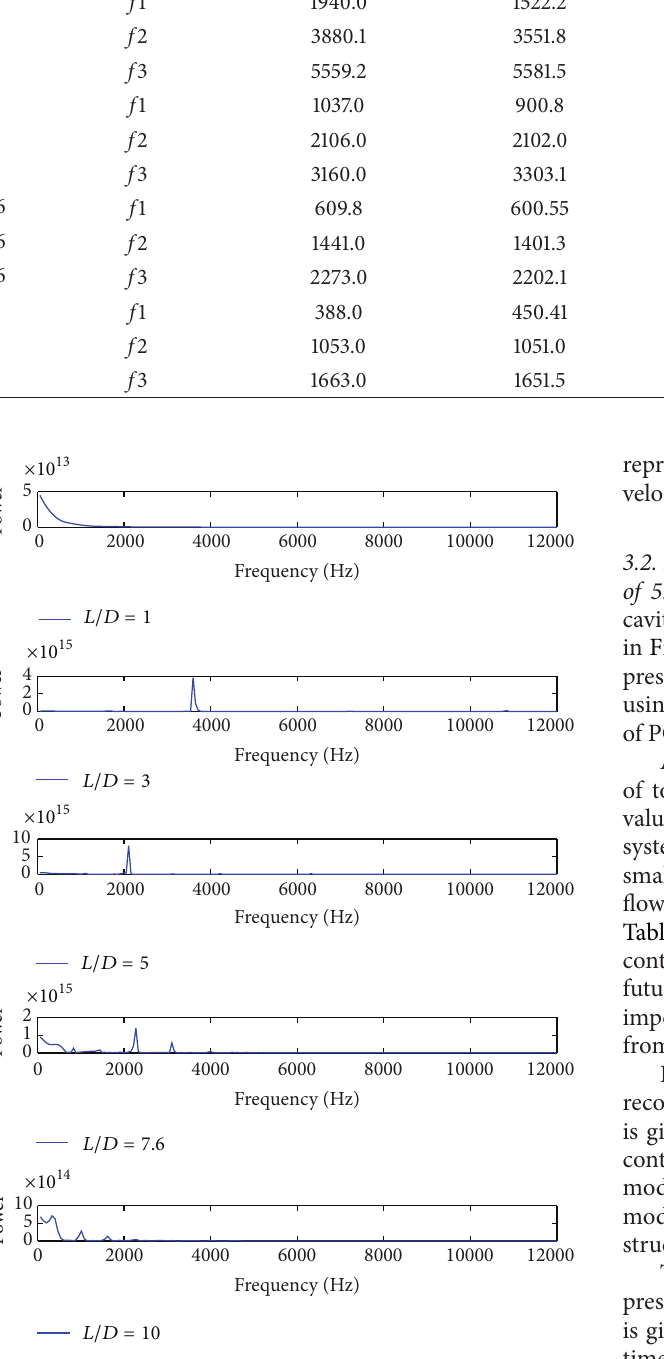
Figure 8: Power spectrum on the aft bulkhead y/D = 0.6.